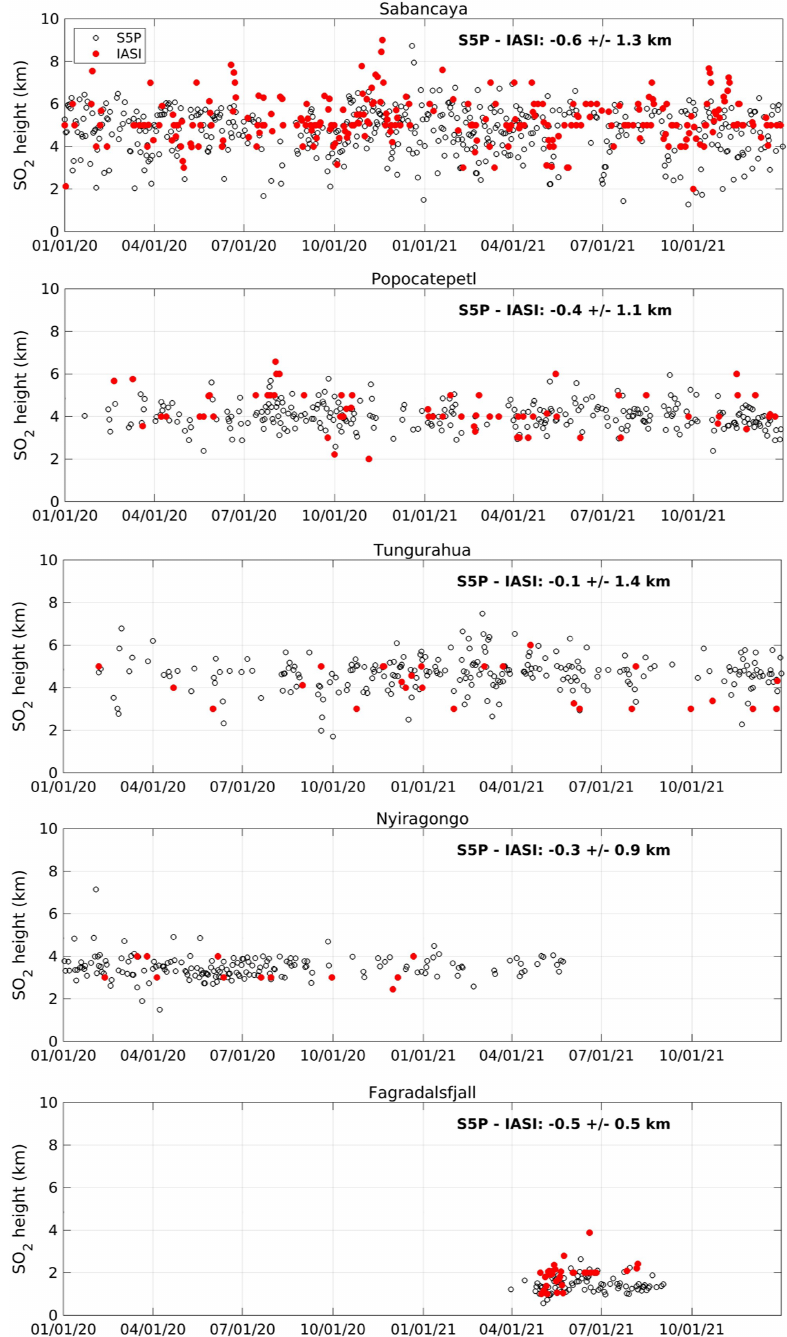
Figure 8. Time series of SO 2 height over five volcanic regions from TROPOMI and IASI/MetOp-B (daytime observations) for January 2020 to December 2021. Daily estimates of SO 2 center of mass height were calculated from quality-filtered data using fixed latitude–longitude boxes (from top to bottom) for Sabancaya (12–20 ◦ S, 70–78 ◦ W), Popocatepetl (15–22 ◦ N, 96.5–102 ◦ W), Tungurahua (5 ◦ S–1 ◦ N, 77– 83 ◦ W), Nyiragongo (5 ◦ S–3 ◦ N, 25–32 ◦ E), and Fagradalsfjall (60–70 ◦ N, 10–32 ◦ W). For IASI, the same VCD lower threshold of 5DU as TROPOMI is applied to select the data. The calculated SO 2 heights are shown only for days with at least 2 pixels. The mean and standard deviation of the differences between TROPOMI and IASI SO 2 daily heights for the complete period are given as an inset for each